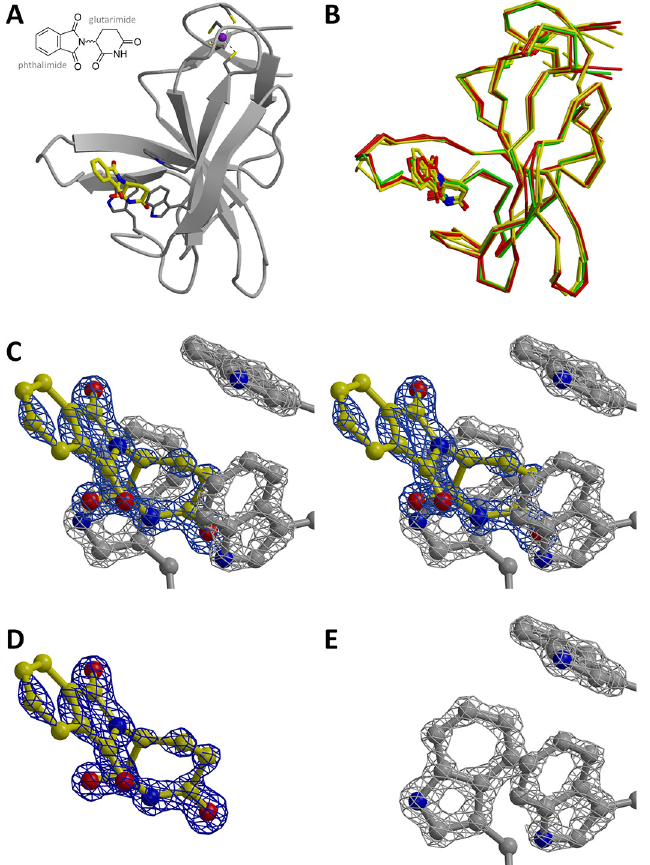
Fig 1. Atomic resolution structure of MsCI4 (cid:129) thalidomide. (A) The overall structure of MsCI4 (cid:129) thalidomide from the trigonal crystal form. (B) Superposition of the latter (in green) with the three MsCI4 (cid:129) thalidomide monomers from the orthorhombic crystal form (4V2Y, in yellow) and the two MsCI4 (cid:129) thalidomide monomers from the hexagonal crystal form (this work, in red). While the conformation of the protein and the glutarimide moiety is virtually identical, the orientation of the phthaloyl moieties differ by up to 13° between the structures. (C) Stereo close-up of the thalidomide molecule and the three tryptophan residues of the aromatic cage of the atomic resolution structure, together with an omit electron density map at 1.2 Å resolution. The omit map was calculated for thalidomide and the three indoles and is contoured at 6.5 sigma. Whereas individual atoms of the indoles and of the glutarimide ring are sharply localized in the density, the phthaloyl moiety is poorly resolved due to thermal disorder. (D) Only thalidomide with omit map. (E) Only the tryptophans with omit map.